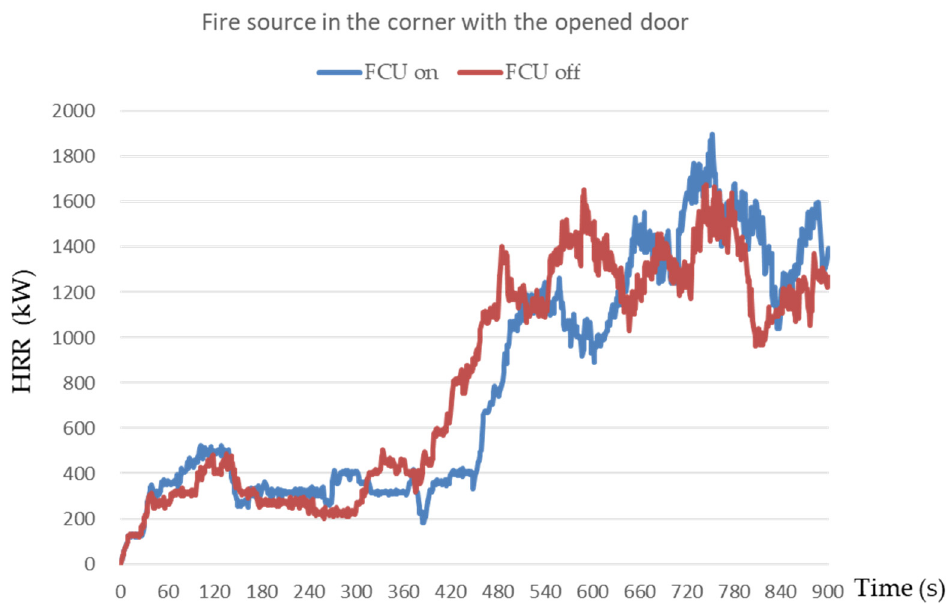
Figure 10. The HRR for different actions of the air inlet with the fire in the corner of the square room.